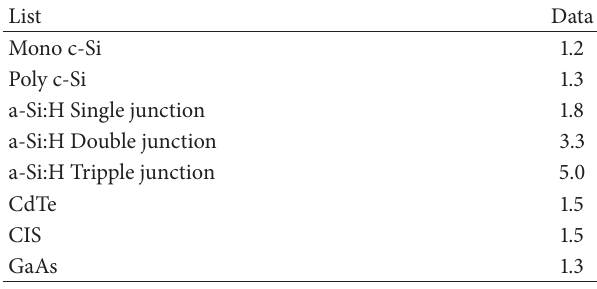
Table 1: The ideal factor is dependent on PV technology.